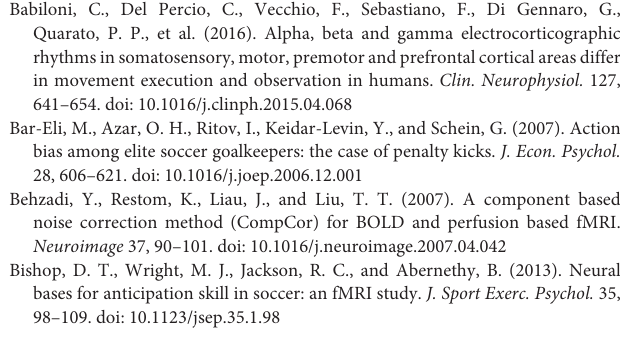
SUPPLEMENTARY FIGURE 1 | Observed scores (red vertical line) and distribution of permuted scores (blue histogram) for each participant-specific IMG/ATT model cross-validated to the trials from the penalty-reading task. Scores (x-axis) represent the proportion of correctly anticipated trials predicted as IMG (or, equivalently, the recall